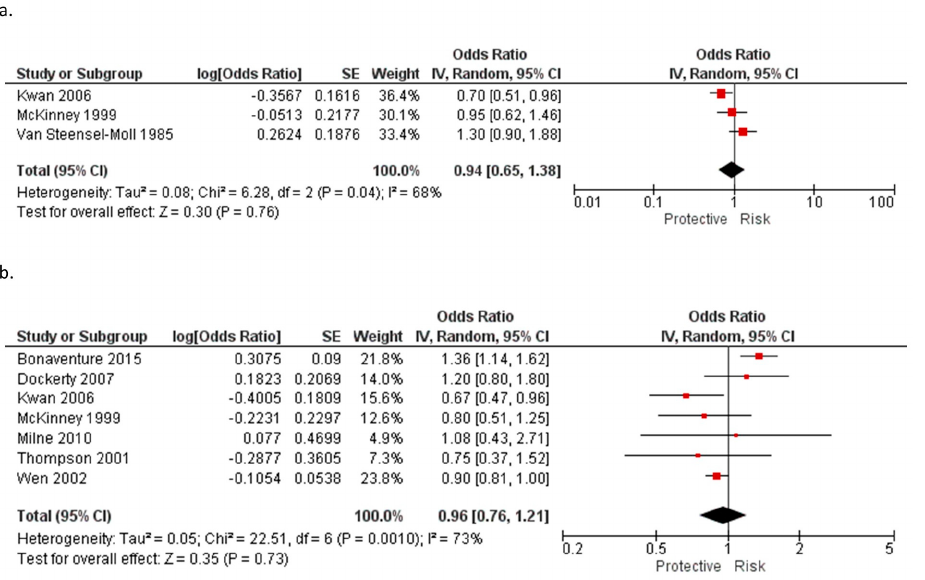
Figure 4. Meta-analysis of the association between the supplementation with iron during pregnancy and ( a ) acute leukemia [32,34,35] and ( b ) acute lymphoblastic leukemia [30,32,35,39,42,43,45]. Note: the individual estimate (OR) from the studies are represented by the red box, and the black diamond represent the estimate of the